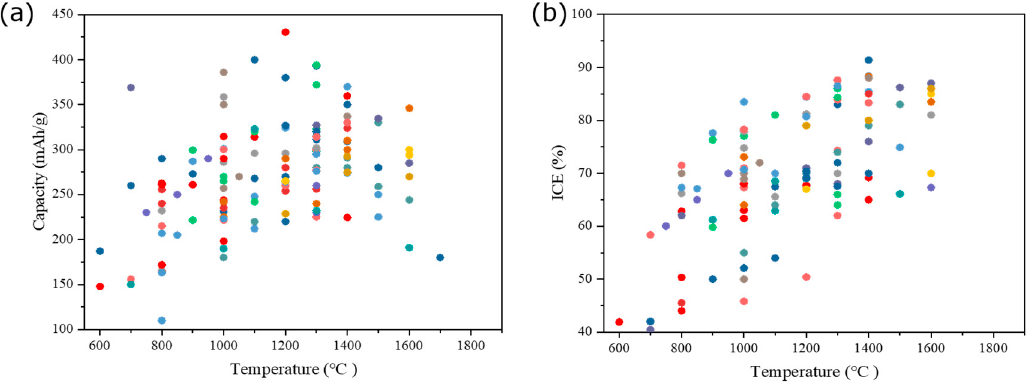
Figure 7. The relationship between carbonization temperature and HC anode performance: ( a ) capacity; ( b ) ICE. Different colored dots represent different biomass precursor [21,47,55–58,62,64,78,79,81–84,91–114].